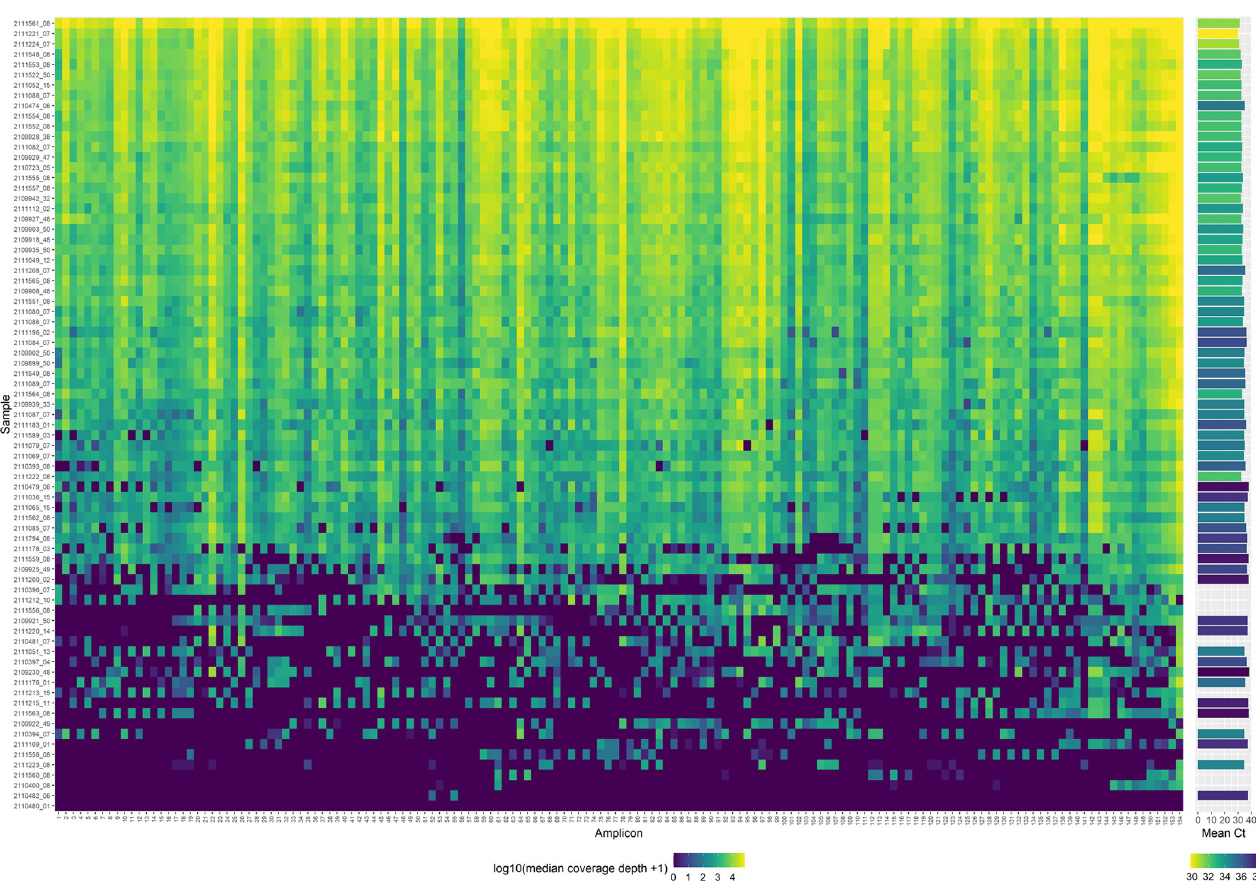
Fig 8. Coverage depth across the SARS-CoV-2 genome. Heatmap visualising median coverage depth across each amplicon (left) for 77 sequenced wastewater samples, with the associated SARS-CoV-2 Ct value for each sample (right). Ct value of 0 refers to samples for which RT-qPCR failed to identify SARS-CoV-2.